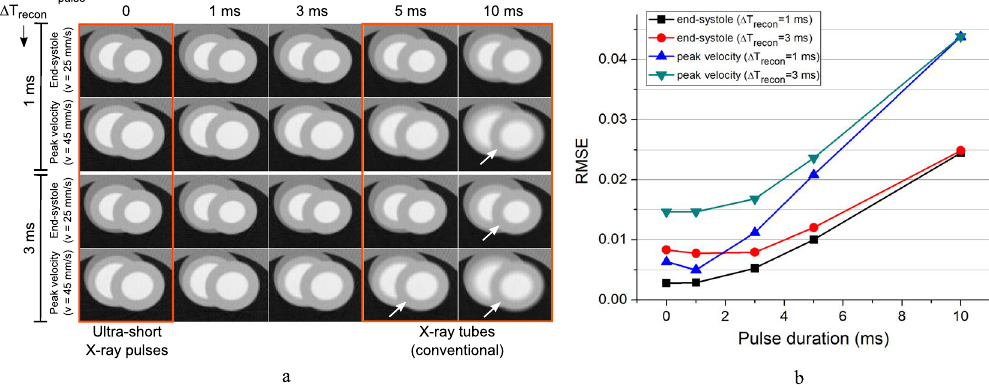
Figure 4. Noiseless simulation showing the motion blurring for different duration of the reconstruction window Δ T recon and the X-ray pulse Δ T pulse , reconstructed at end-systole ( v = 25 mm/s) and at time of peak myocardial velocity ( v = 45 mm/s). ( a ) Reconstructed images in the transaxial plane ( xy ); the white arrows indicate settings leading to non negligible motion blurring. All images have been reconstructed by FBP with a voxel size of 100 μ m from 240 projections per cardiac phase, taken at 1.5° sampling interval. ( b ) RMSE analysis relative to a reconstruction of the same ROI otained with a fixed reconstruction window of negligible duration, Δ T = 1 μ s (reference image not recon